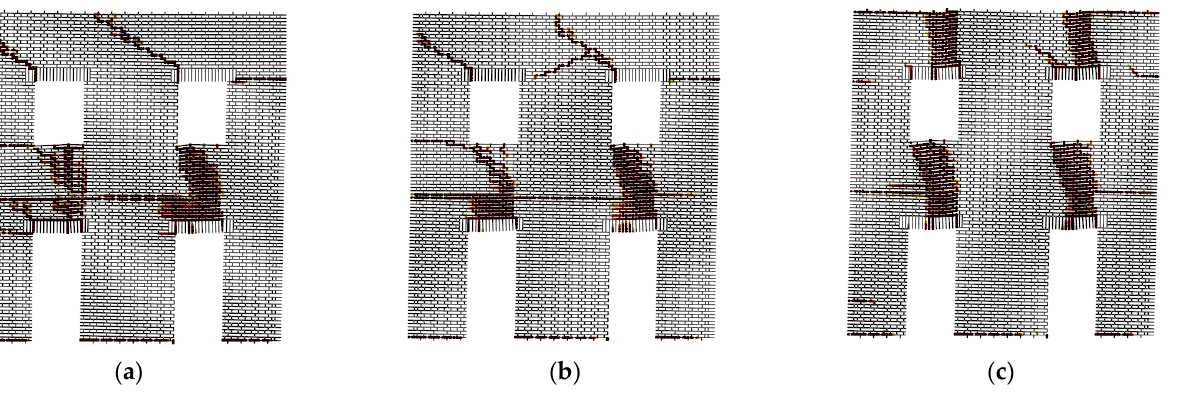
Figure 7. Crack pattern of the masonry wall corresponding to an IDR of the first level equal to 2% for ( a ) VL-a, ( b ) VL-b, and ( c ) VL-c.